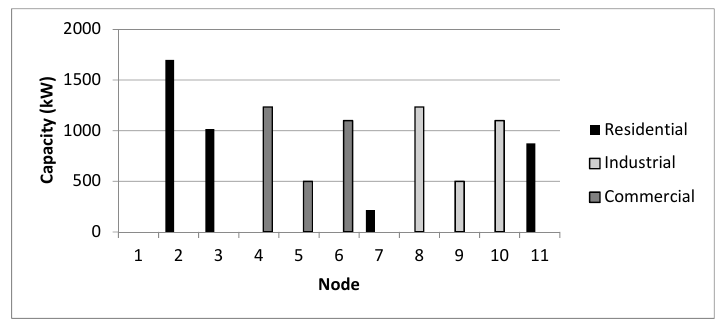
Figure 2. Structure of loads connected to the benchmark network model. Own study.